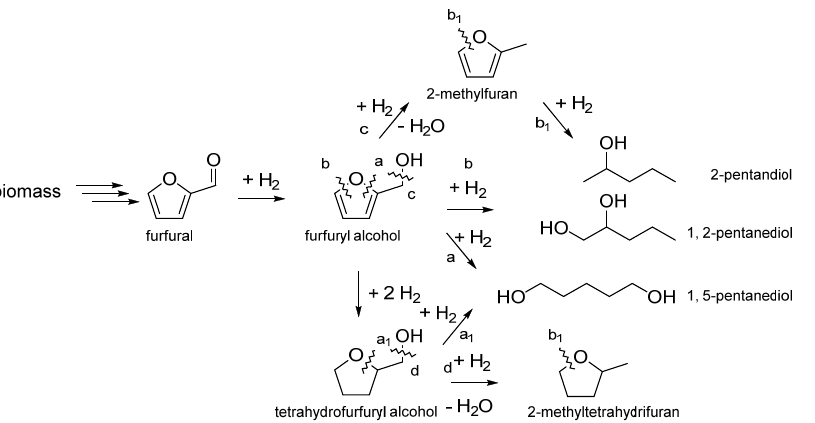
Scheme 1. Simplified reaction scheme of the catalytic hydrogenation of biomass ‐ derived furfural into several valuable